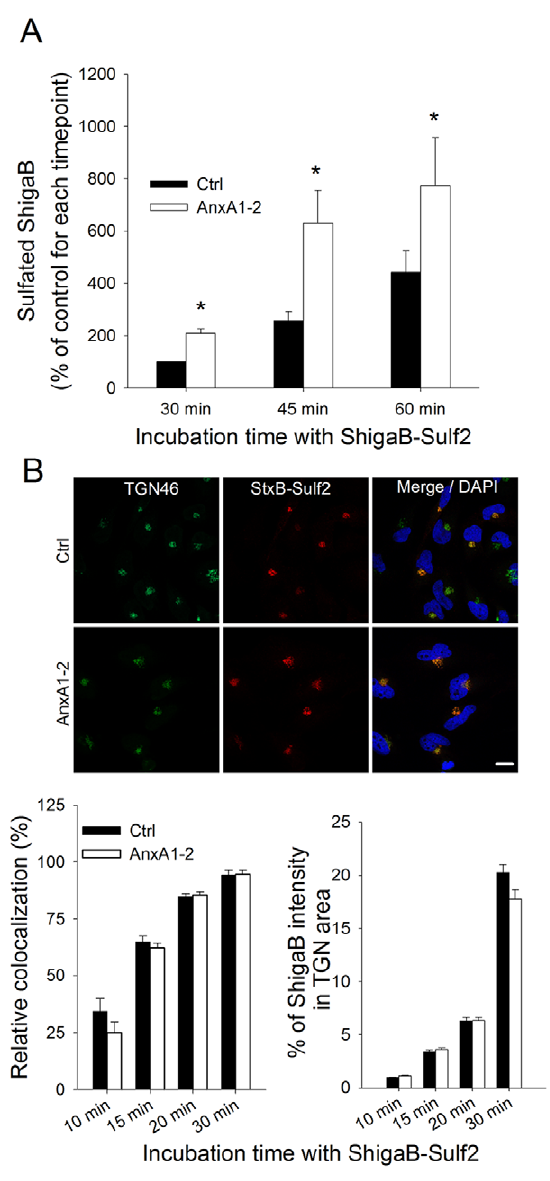
Figure 3. Time course of ShigaB sulfation in annexin A1 or A2 depleted cells. (A) HeLa cells transfected with control or annexin A1 siRNA for 72 h were analyzed for the amount of ShigaB being sulfated at different time points after addition of StxB. Sulfation data are plotted as percentages of the amount of sulphated ShigaB after 30 min incubation with control siRNA treated cells. Black and white bars represent sulfation of ShigaB in control and annexin A1 siRNA treated cells, respectively. Data presented are the average of 3–4 independent experiments, each performed in parallel, error bars indicating standard error of the mean, *p , 0.05; **p , 0.005 indicates statistically significant change. (B) After the same treatment as in (A), cells were fixed and stained with antibodies against TGN46 and ShigaB. Top panel shows representative confocal pictures for 30 min incubation with StxB, scale bars 20 m m. Left graphic shows quantification of amount of ShigaB colocalized with TGN46. In the right graphic, mean intensity of ShigaB in the Golgi area for the same representative experiment is plotted as percentage of mean intensity in the whole cell. Data presented are the average of at least 35 cells per condition. Quantifications where obtained with ImageJ software, error bars indicating standard error of the